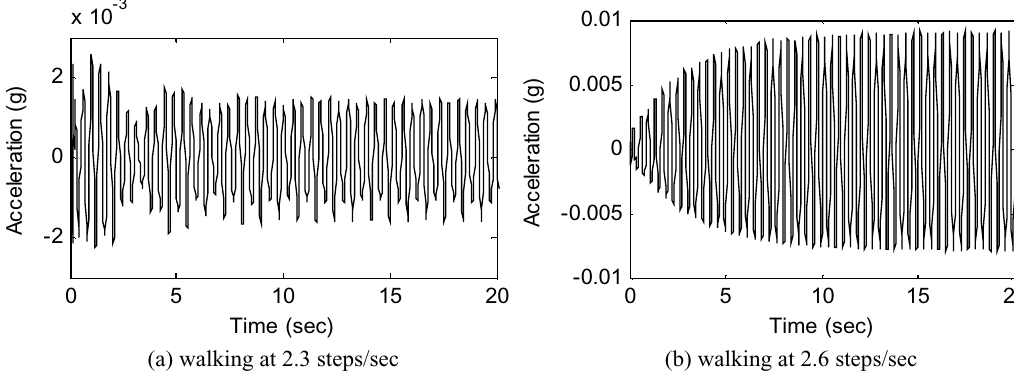
Fig. 3. The floor maximum vertical acceleration vs. time